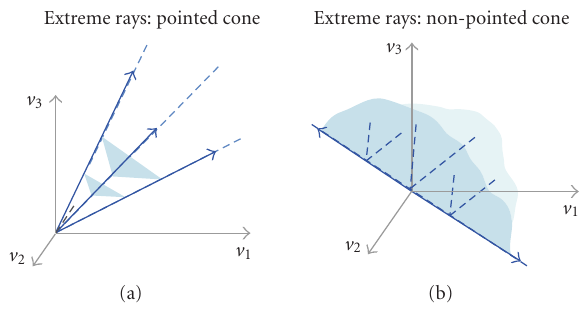
Figure 1: Extreme rays of two flux